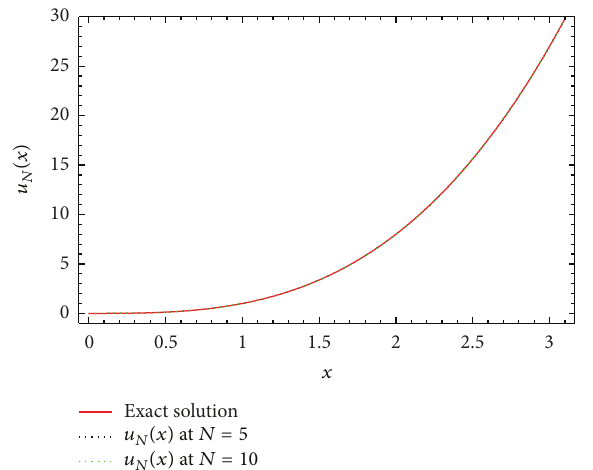
Figure 4: Comparing the exact solution and the approximate solutions at 𝑁 = 5, 10 and 𝛼 = 1